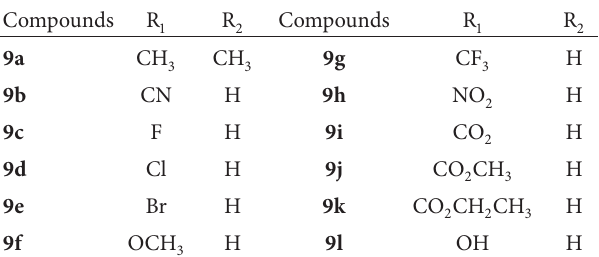
Table 2: List of compounds